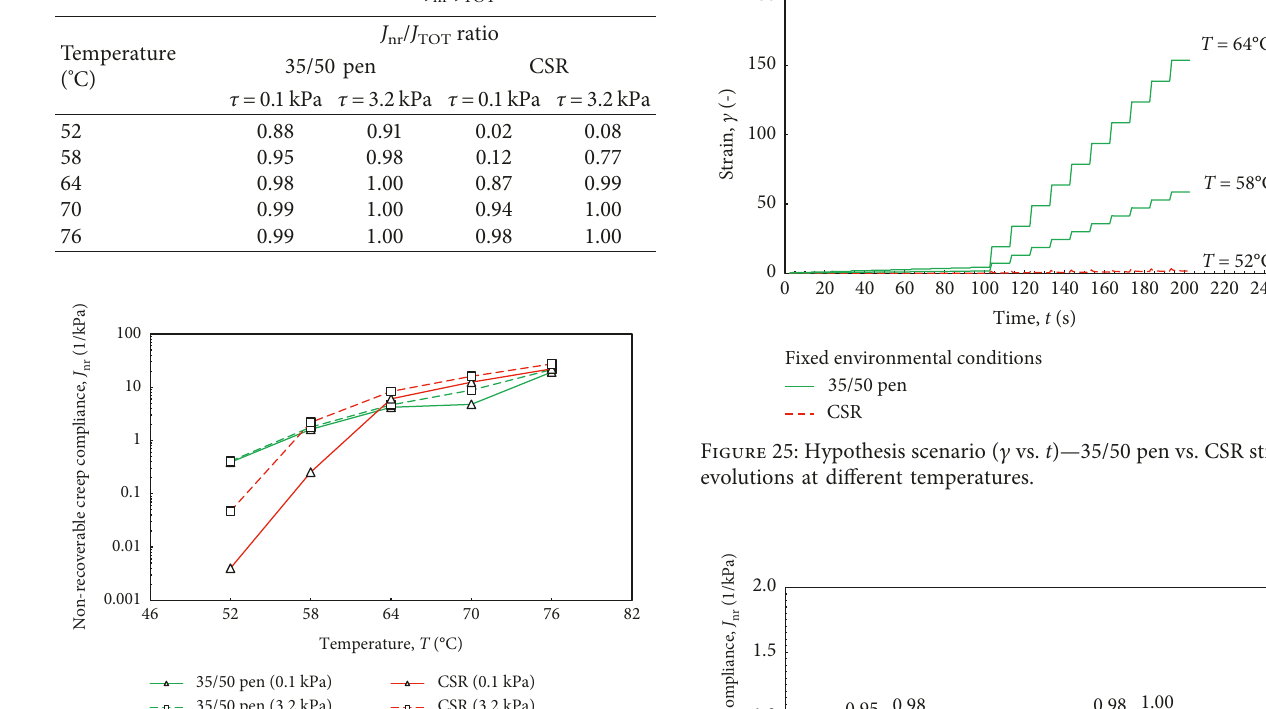
CSR (0.1 kPa) CSR (3.2 nr vs. T )—35/50 pen vs. CSR